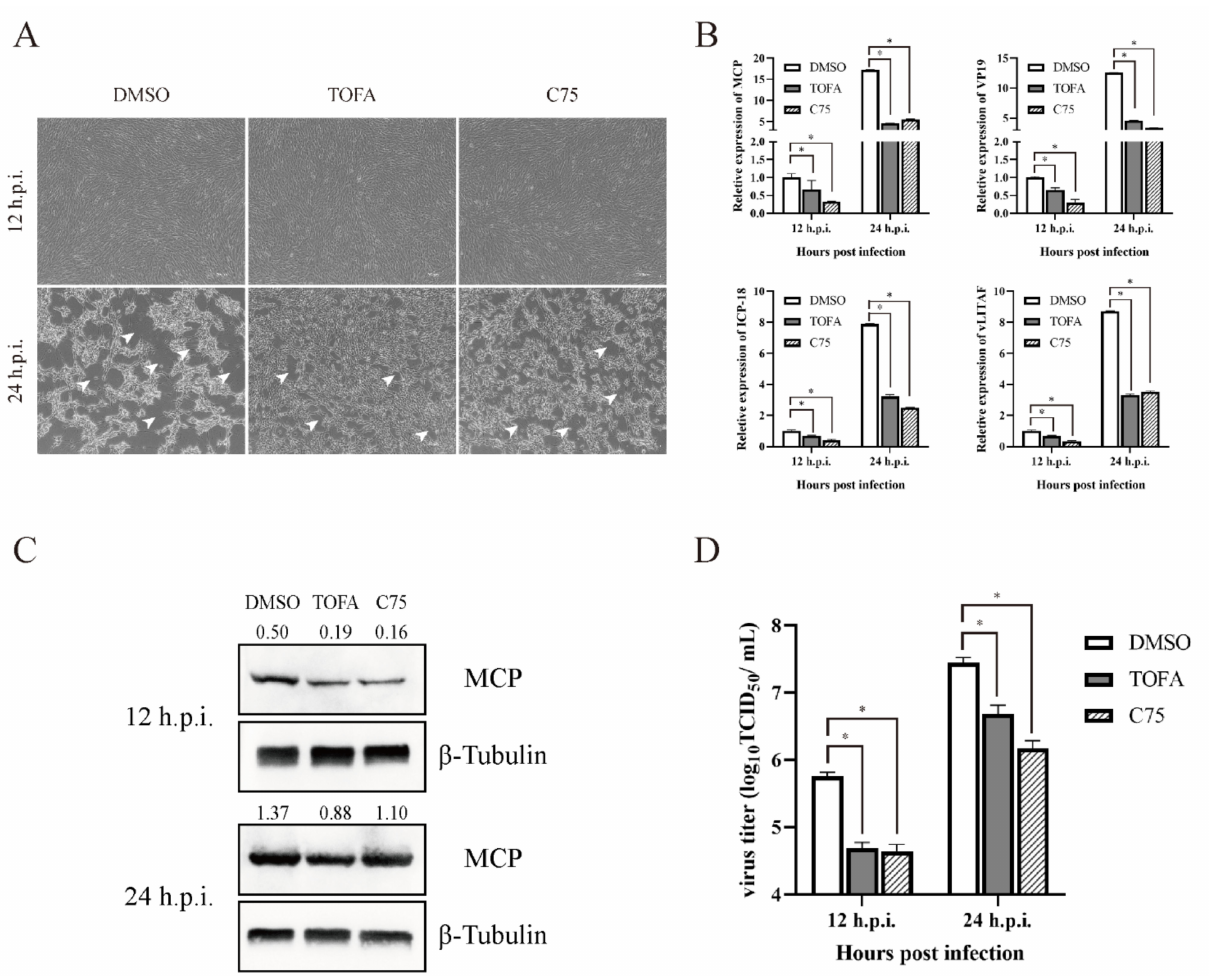
Figure 3. Roles of fatty acid synthesis during SGIV replication. CPE of TOFA and C75 on GS cells during SGIV infection ( A ). Effects of TOFA and C75 on SGIV genes transcription during SGIV infection ( B ). Effects of TOFA and C75 on SGIV MCP protein expression during SGIV infection ( C ). Effects of TOFA and C75 on SGIV TCID 50 during SGIV infection ( D ). n = 3, data are expressed as means ± SD, * indicates p <